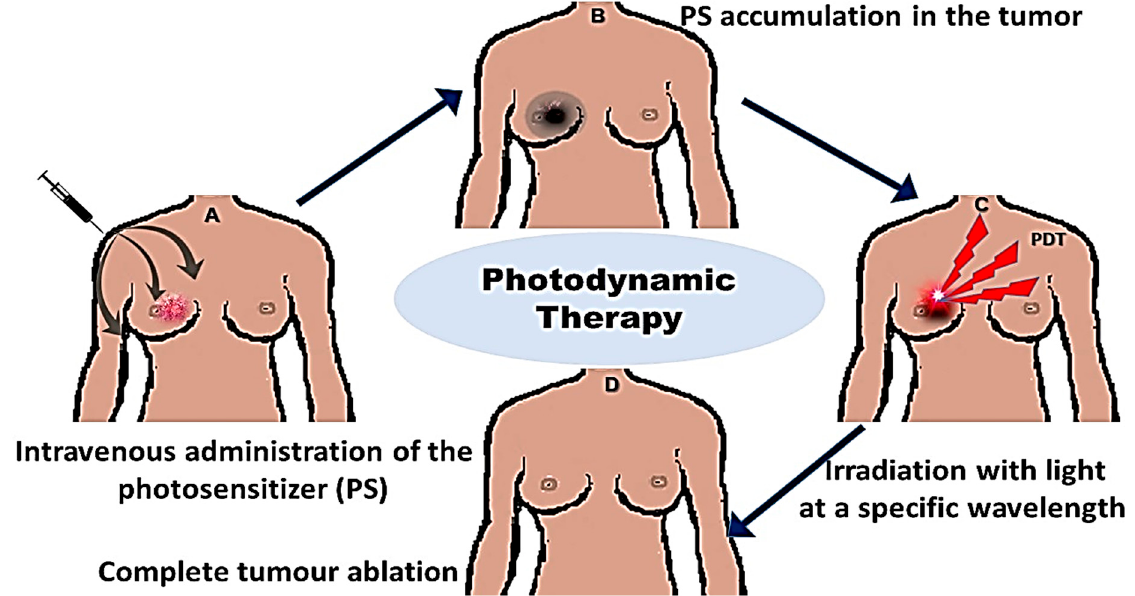
Figure 1. PDT treatment scheme. Intravenous administration of the PS, which localizes on the tumor site and results in tumor ablation, when light at a specific wavelength is applied.